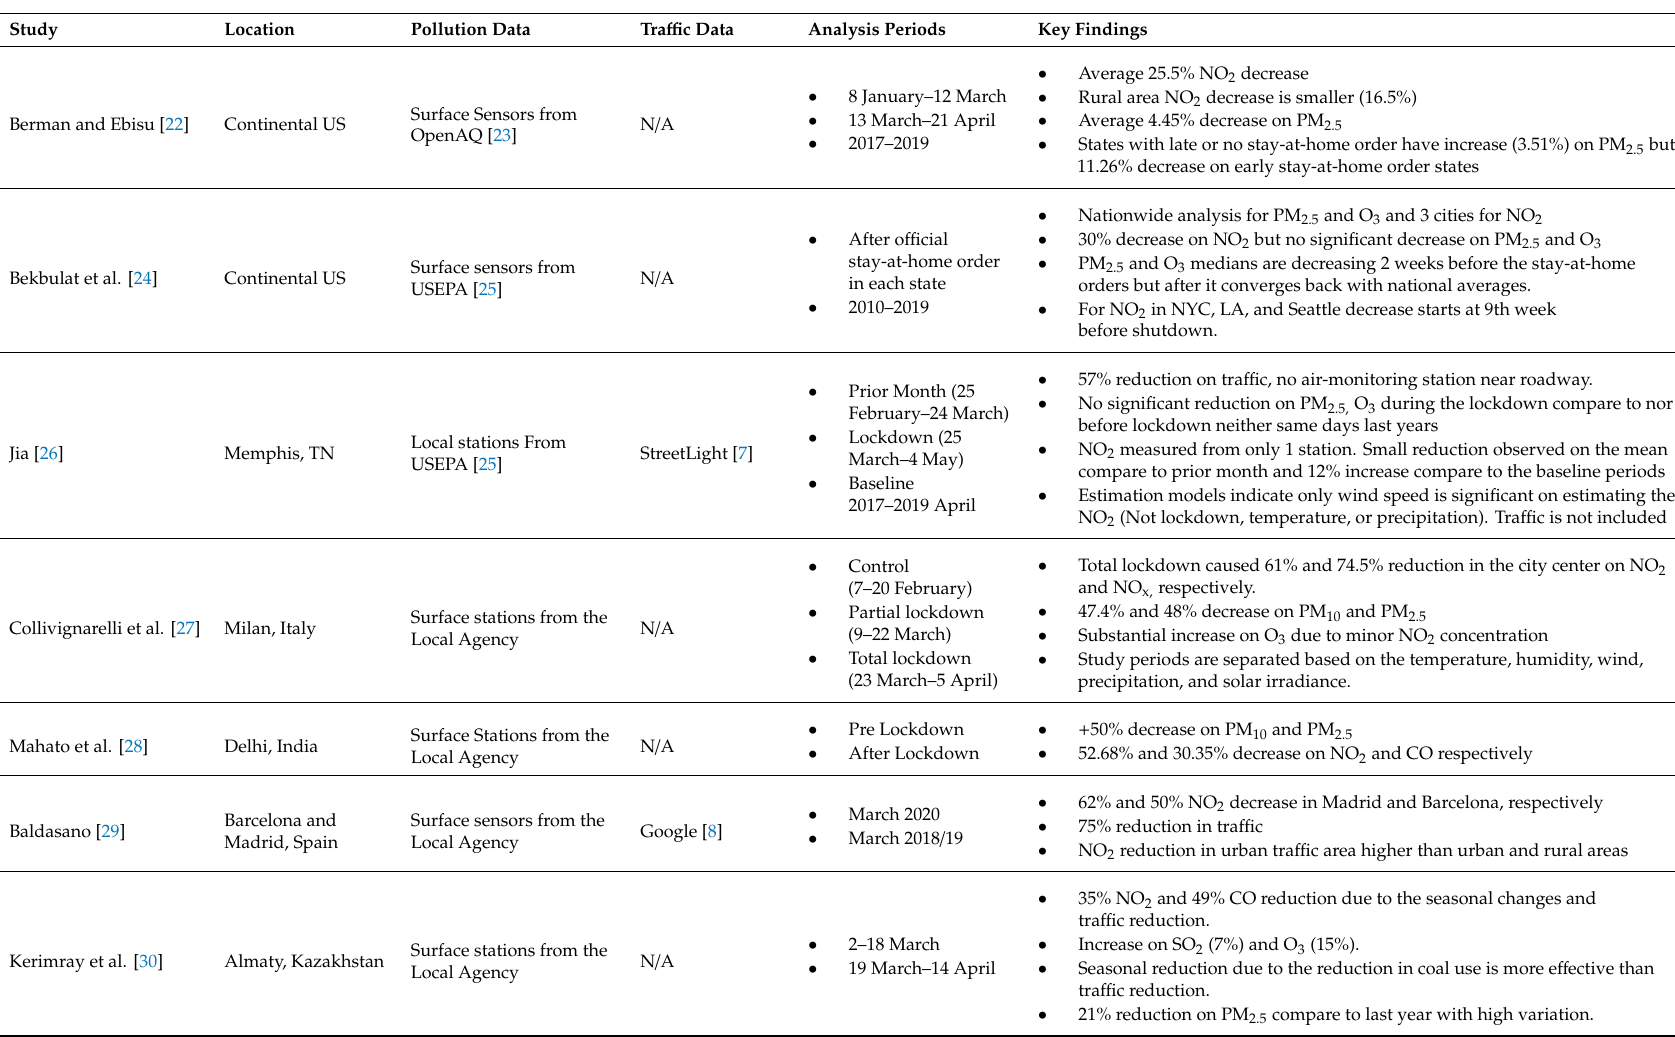
Table 1. Example studies of COVID-19 impacts on air quality and their